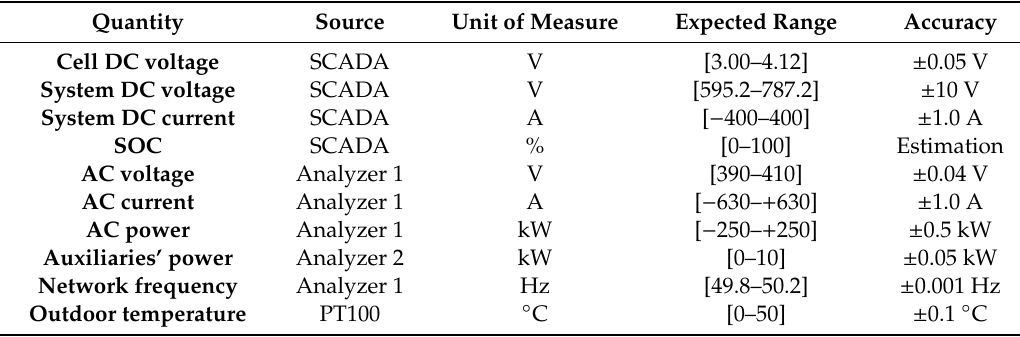
Table 2. Metadata of relevant measured quantities